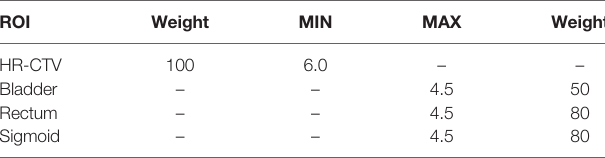
TABLE 1 | The optimization objectives for GBPO plans (Dose unit: Gy).